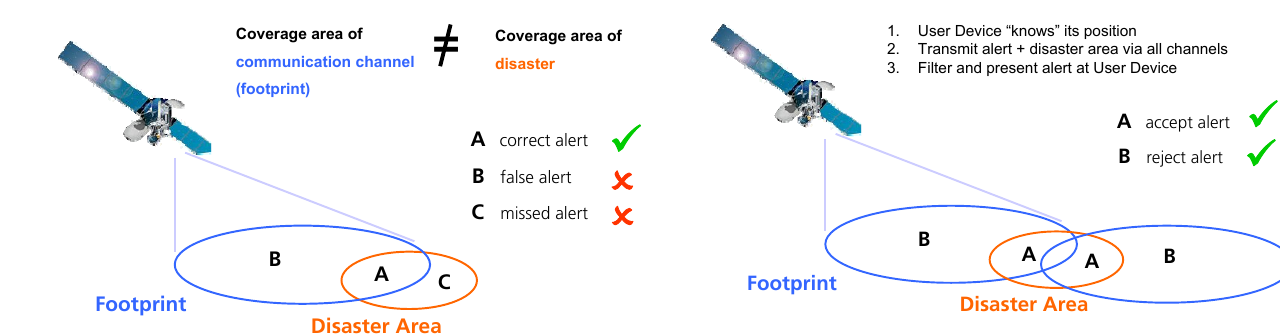
Fig. 14. A mismatch of the affected area with the coverage area of the communication channel utilized to transport the warning leads to missed alerts and false alerts.